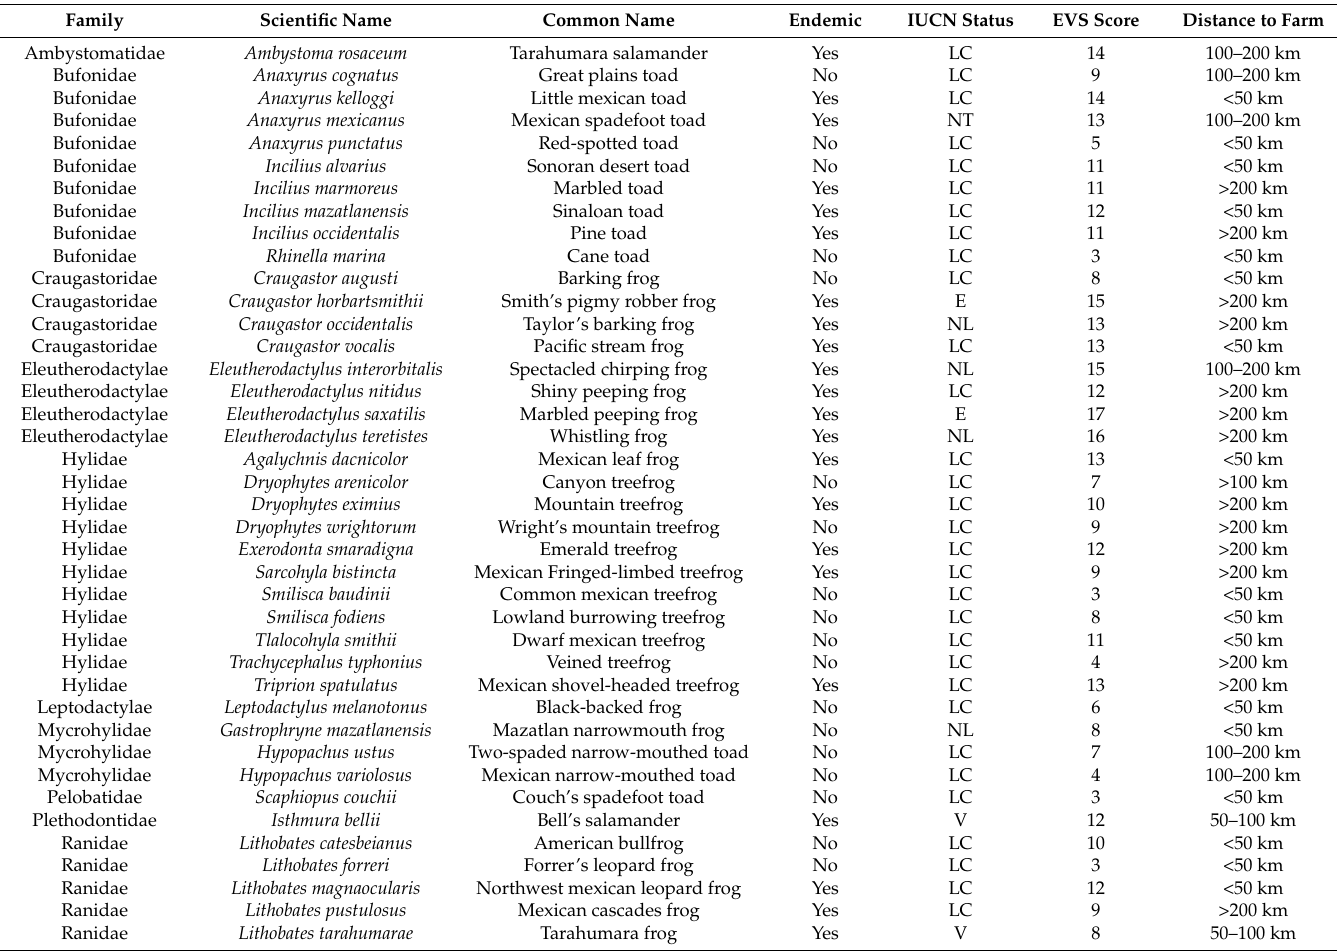
Table 2. Level of threat for native amphibian species within the province of Sinaloa. The table summarizes the endemic, IUCN, and EVS, status and estimated distance of the nearest population of specific species to the affected